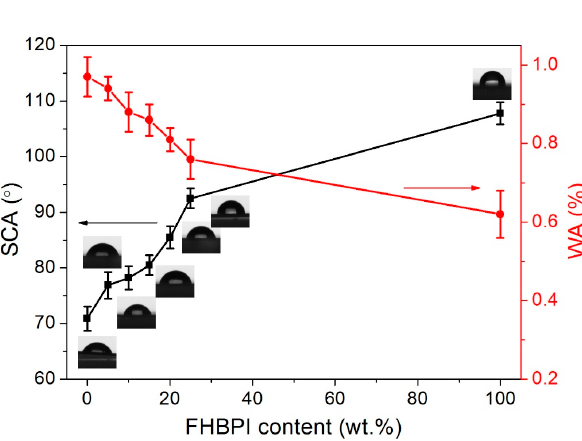
Figure 12. Effects of FHBPI content on SCA and WA of FPI composites. Figure 12. E ff ects of FHBPI content on SCA and WA of FPI